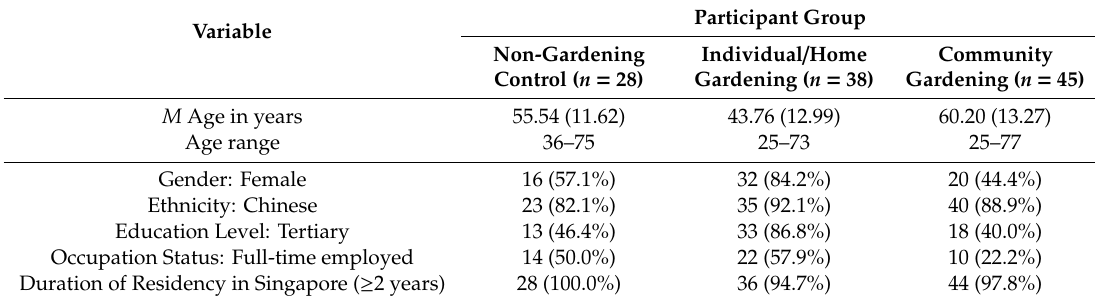
Table 1. Demographic Characteristics (Means (SD), No. (%)) Across Three